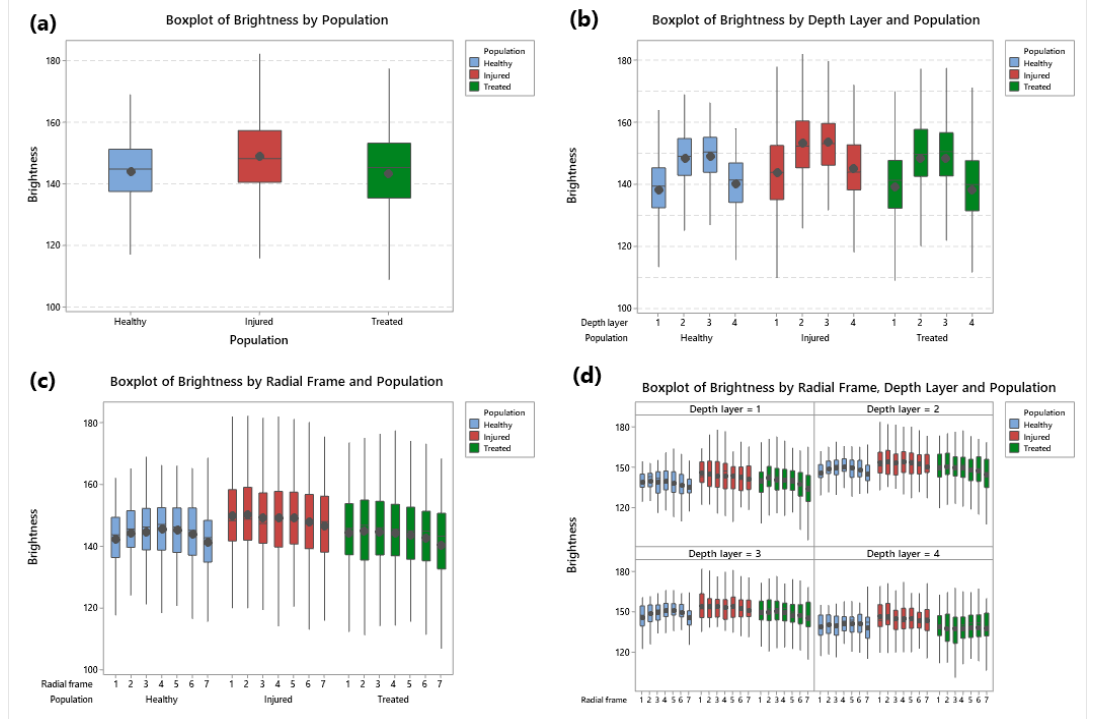
Figure 6. Boxplot representation of the brightness distribution among the corneal populations; ( a ) boxplot images comparing brightness by population; ( b ) by population and depth layer; ( c ) by population and radial frame; ( d ) by population and combination of the depth layer and radial